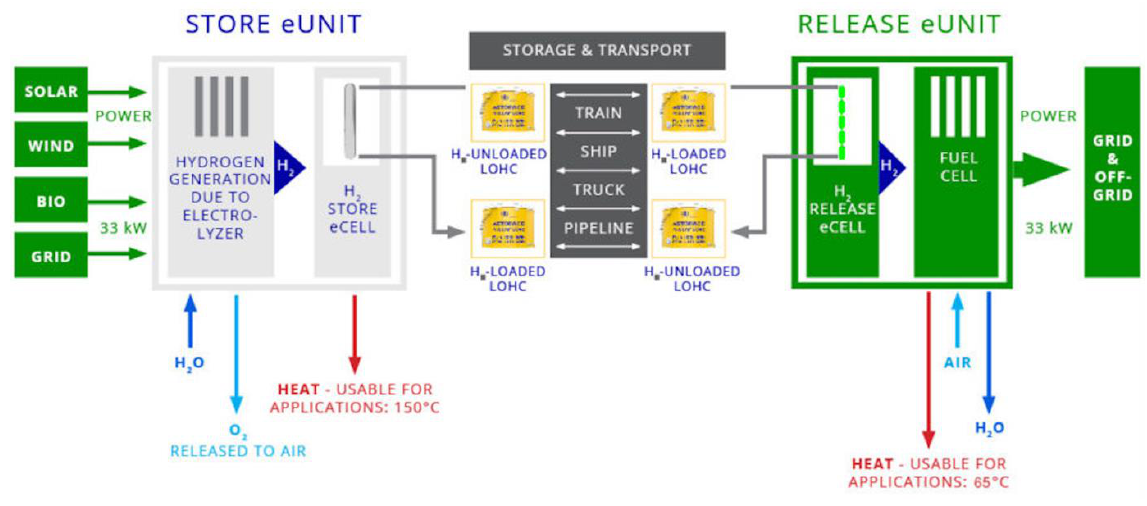
Figure 3 . Scheme of the chemical storage of regenerative electricity via hydrogen with the aid of a reversible hydrogenation reaction